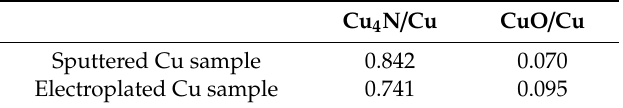
Figure 6. Roughness of plasma treated Cu thin films measured by atomic force microscopy (AFM). Table 2. Qualitative analysis of nitride formation using Cu2p XPS data.